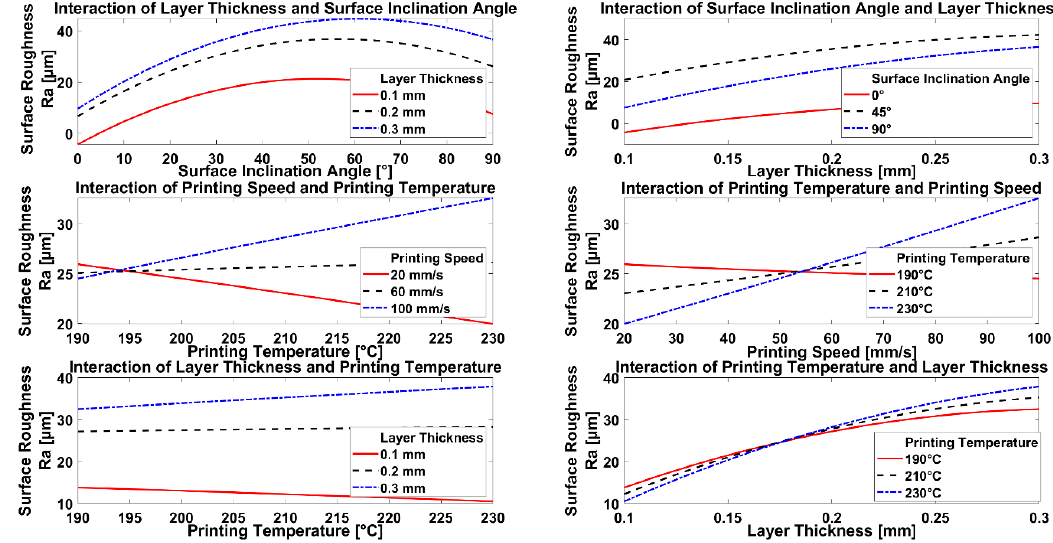
Figure 12. Effects of interaction of parameters on measured R a in X direction. Figure 12. E ff ects of interaction of parameters on measured R a in X